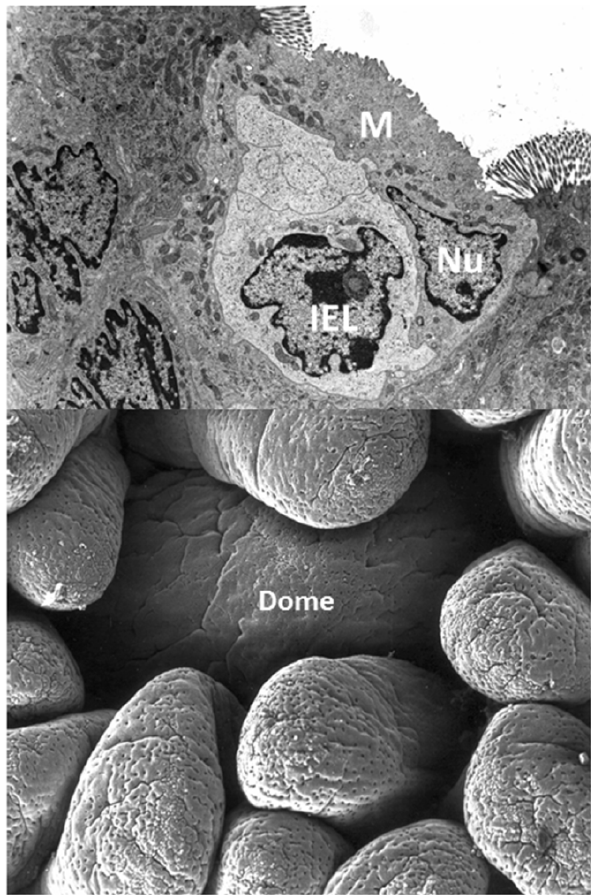
Figure 3. Scanning electron micrograph showing a hemispherical intestinal dome area bulging into the gut lumen and surrounded by intestinal villi. The domes are covered by enterocytes and M cells (M – cytoplasm, Nu – nucleus). Transmission electron microscopy demonstrates the close contact of an M cell with intraepithelial lym- phocytes (IEL). Ileum, rhesus monkey ( Macaca mulatta ).